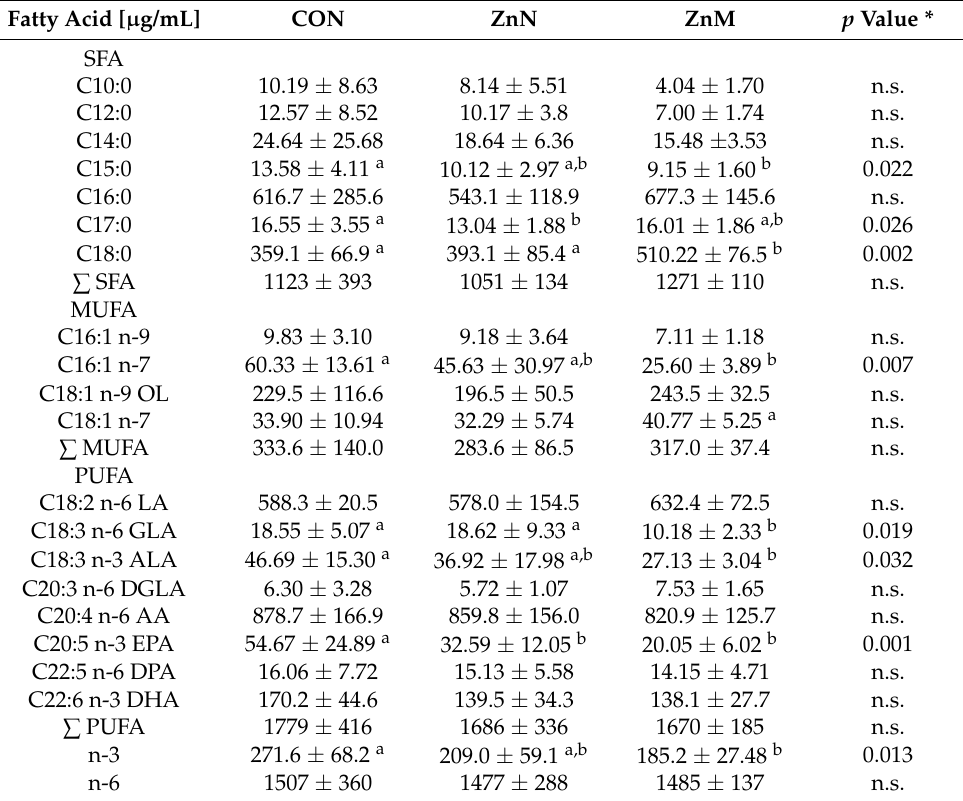
Table 4. Fatty acids (FA) profile in